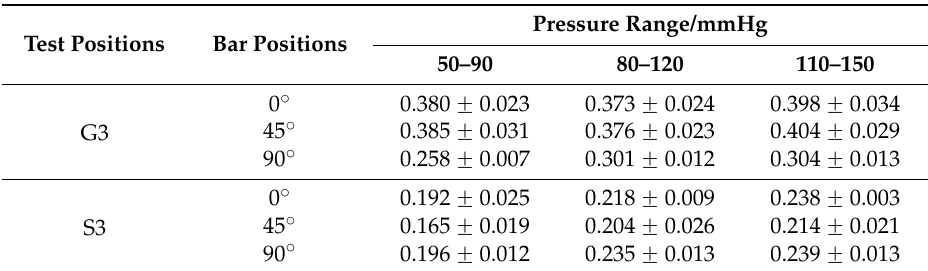
Table 2. Diameter changes in stented zone S3 and unstented zone G3 of the nitinol-PU stent graft under three circumferential bar positions (mm).